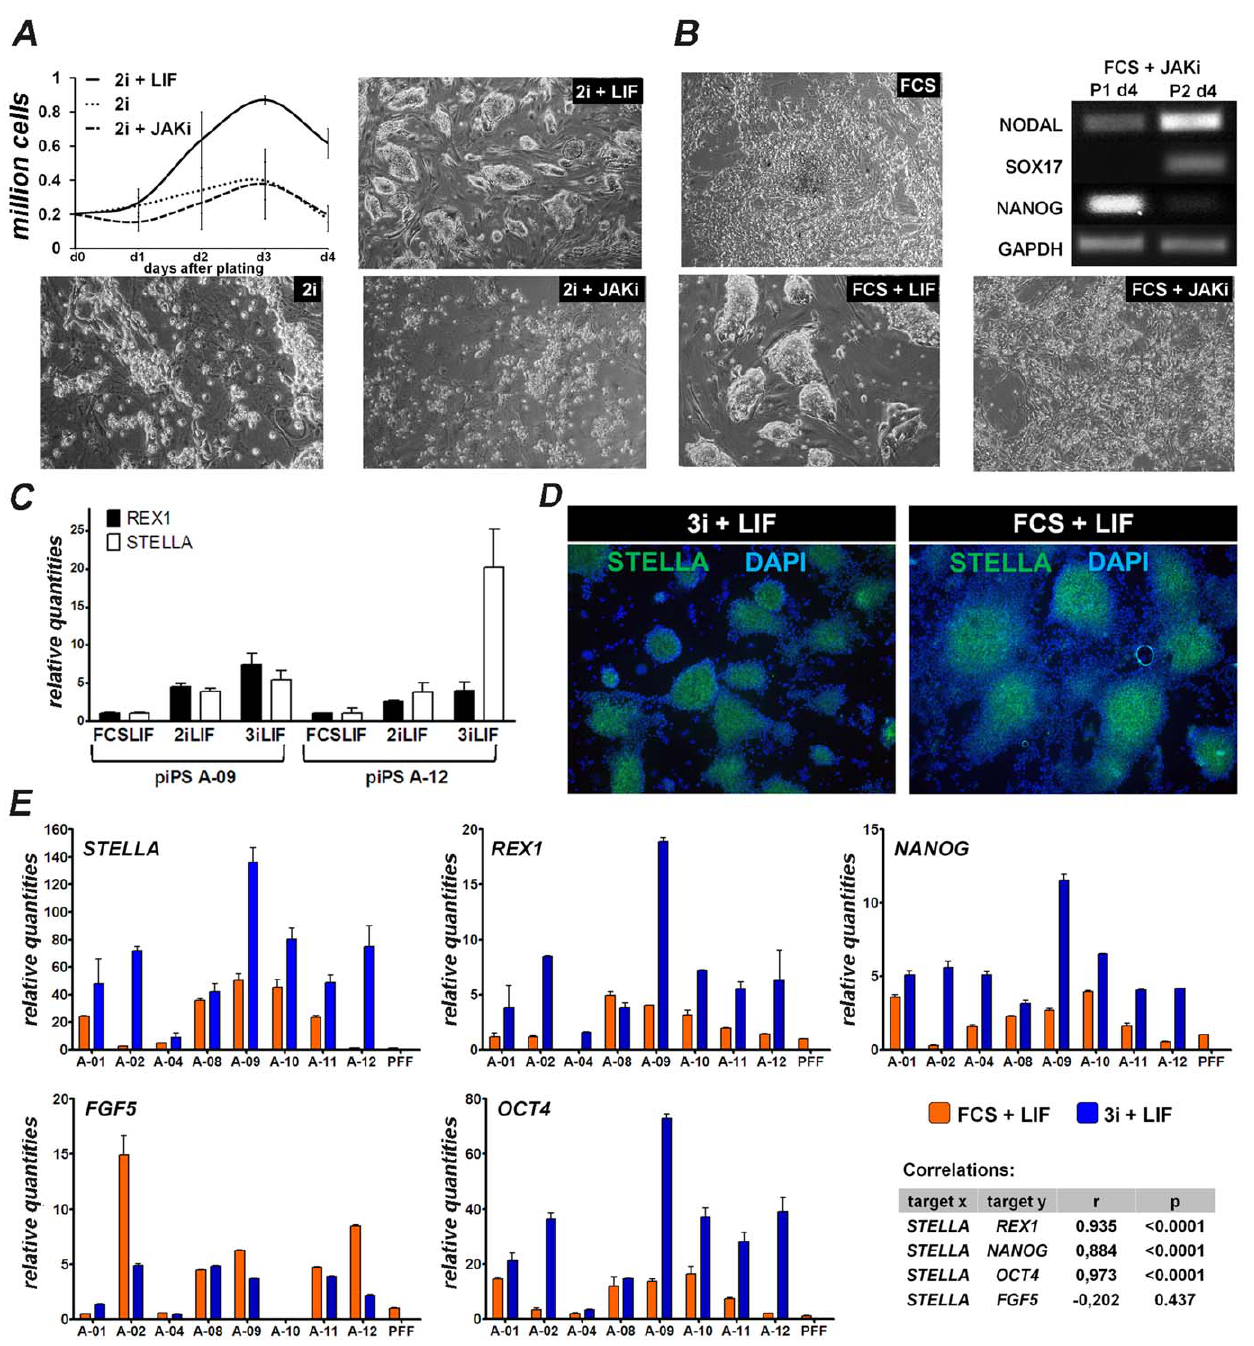
Figure 4. Induction of naive features in piPS cells cultured with 2/3i + LIF. A) piPS cells were seeded in the indicated culture conditions and their growth was quantified daily for 4 days. B) piPS cells were seeded in the indicated culture conditions and collected 4 days after seeding at passage 1 and 2. RT-PCR was performed to analyse gene expression. C) qRT-PCR for REX1 and STELLA of two cell lines grown in FCS + LIF or in 2/3i + LIF. Expression was normalized to FCS + LIF piPS cells. D) STELLA immunostaining in piPS colonies seeded in the indicated culture conditions. E) qRT- PCR for STELLA , OCT-4 , NANOG , REX1 and FGF5 of 8 iPS cell lines grown in FCS + LIF or in 3i + LIF. Expression was normalized to PFF sample. Pearson’s correlation coefficient analysis was performed to study interactions between